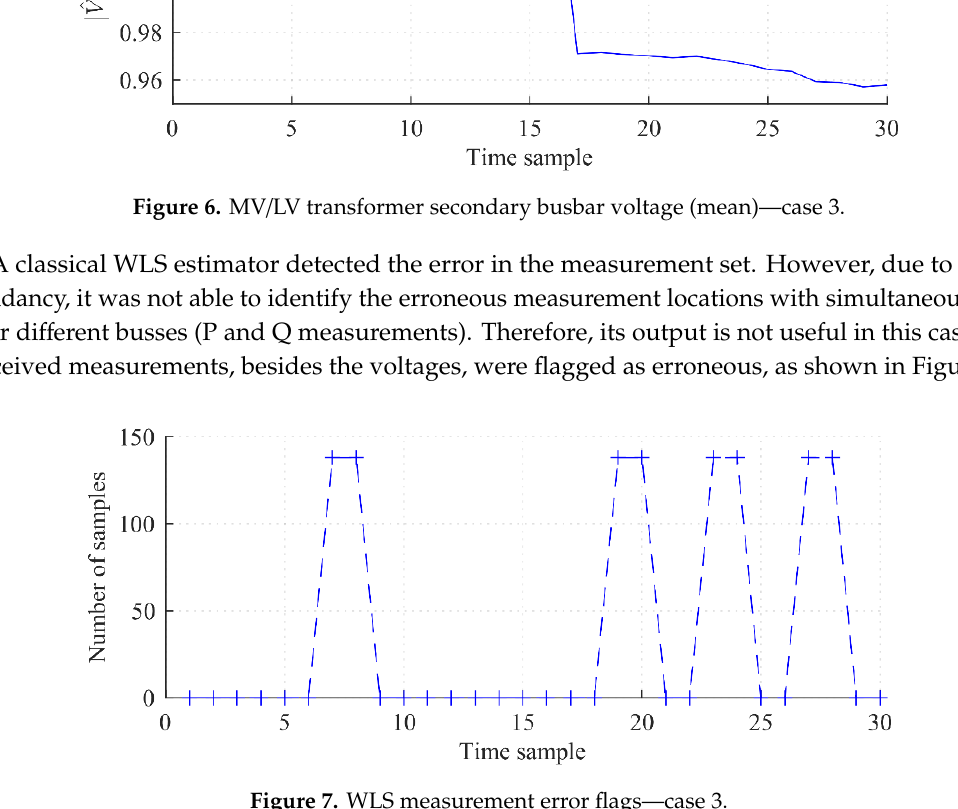
Figure 7. WLS measurement error flags — case 3.